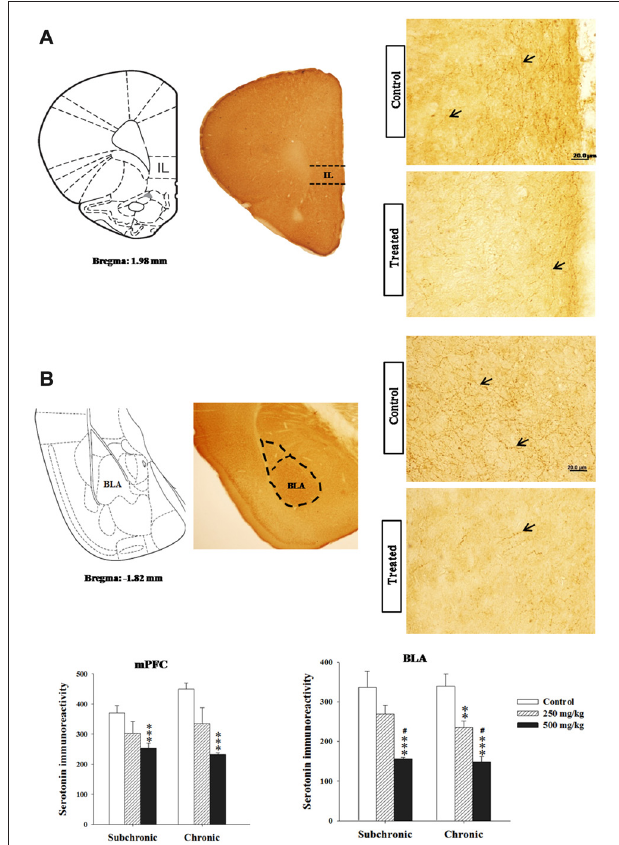
FIGURE 7 | Effect of subchronic and chronic exposure to GBH on serotoninergic fibers. (A) Photomicrographs of mice brain cross sections showing the 5-HT-immunoreactive fibers and the intensity of 5-HT immunoreactivity in the mPFC. (B) Photomicrographs of mice brain cross sections showing the 5-HT-immunoreactive fibers and the intensity of 5-HT immunoreactivity in the basolateral nucleus of the amygdala. mPFC, ventral medial prefrontal cortex; BLA, basolateral nucleus of amygdale; IL, the infralimbic cortex corresponding to the ventral mPFC. The arrows refer to 5-HT fibers. Results are presented as mean ± SEM. ∗∗ P < 0.01; ∗∗∗ P < 0.00. The ∗∗∗ refers to the control vs. 250 mg/kg and 500 mg/kg group comparison and the “#” refers to the 250 mg/kg vs. 500 mg/kg group comparison. # P < 0.05: the post hoc